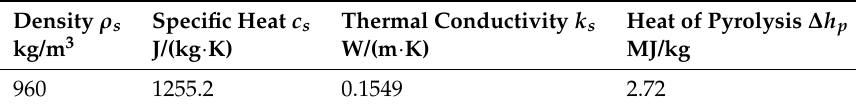
Table 2. HDPE properties